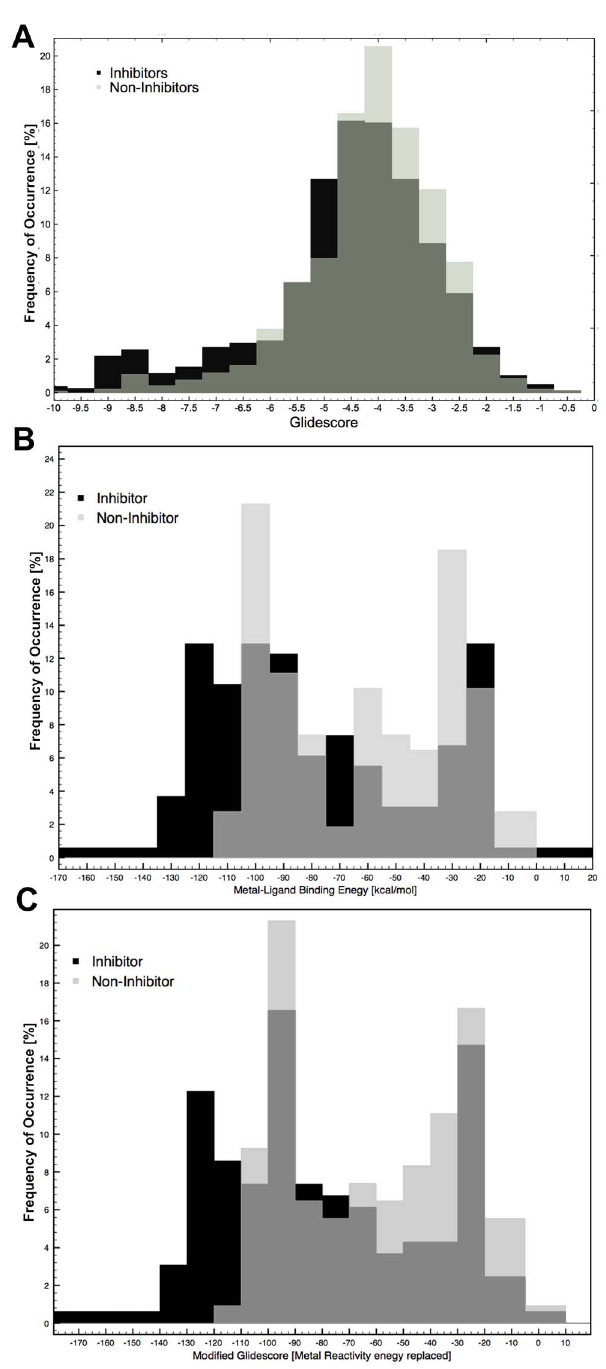
Figure 5. Distribution of binders and non-binders. A. Distribution of binders and non-binders based on the docking scores; B. Calculated chelation energy score; C. Modified Chelation Score.